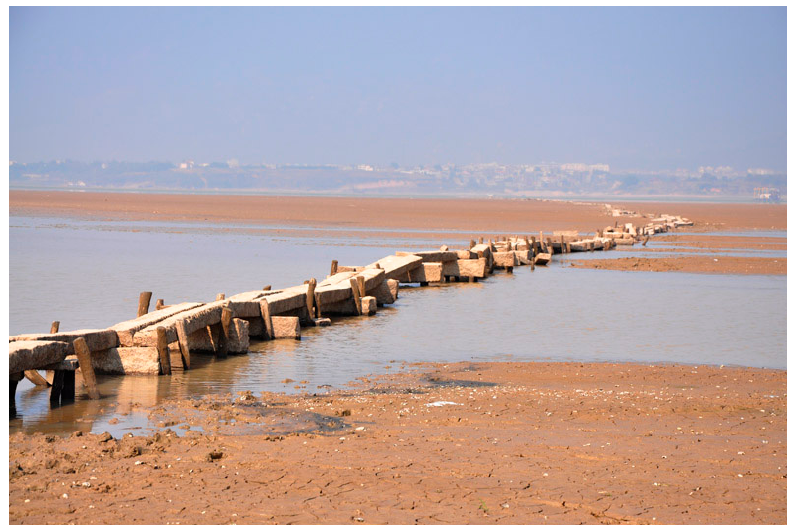
Figure 1. The “thousand-eye bridge” built in the Ming Dynasty in the main navigation channel of Poyang Lake (source: http://dcx.jxnews.com.cn).